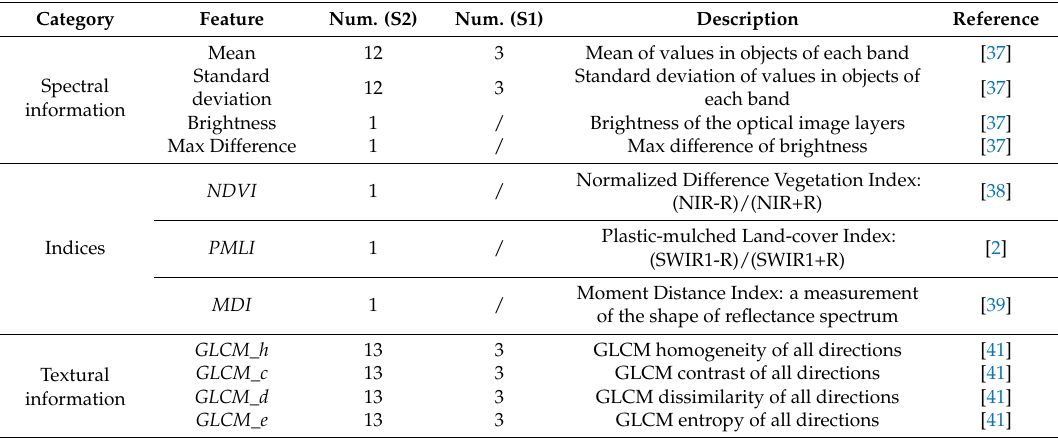
Table 1. S1 and S2 object-based